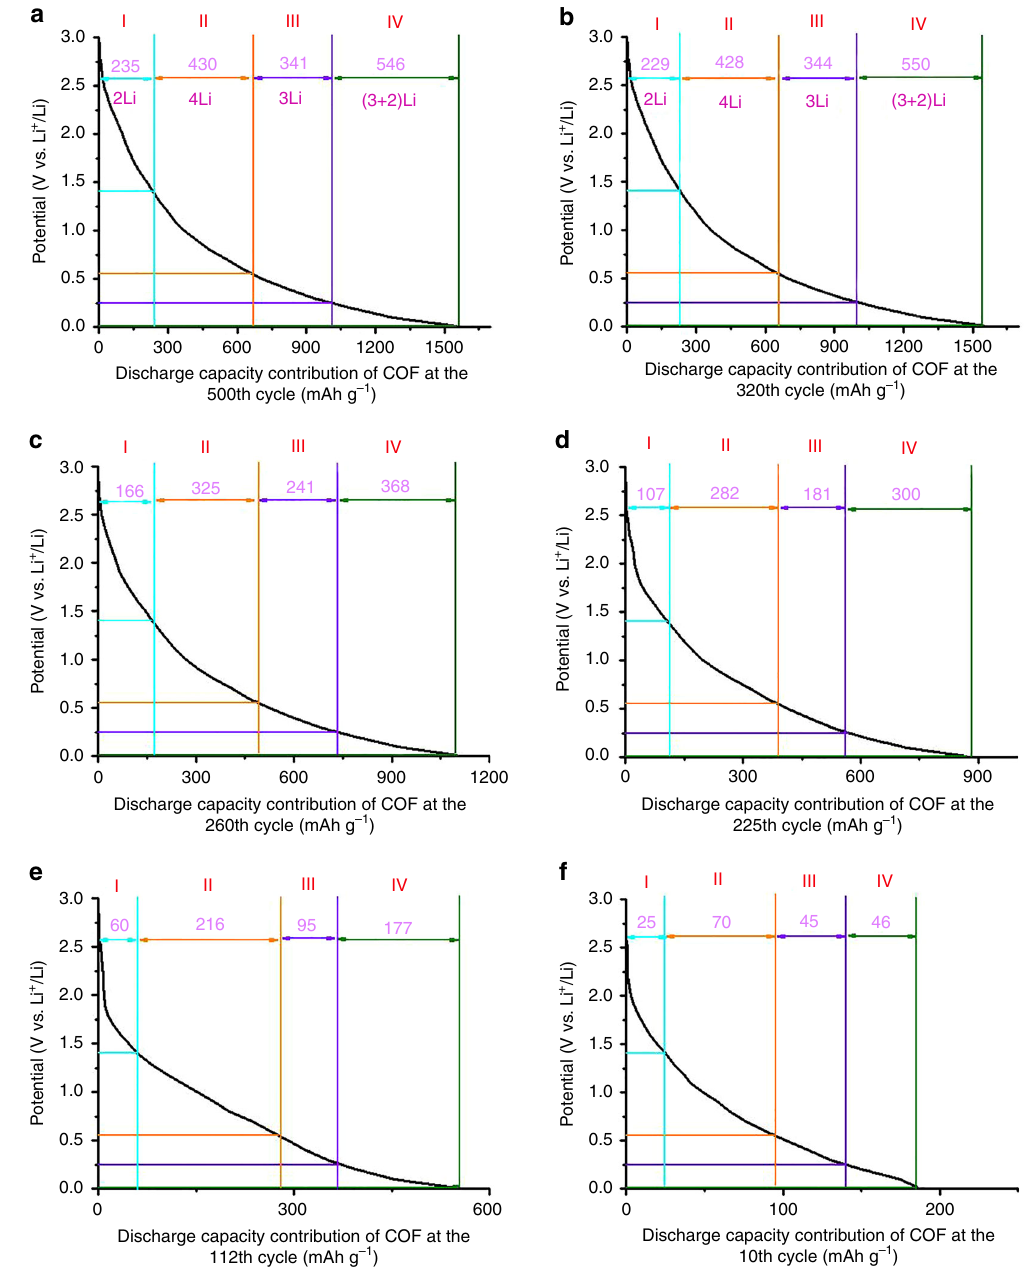
Fig. 9 Discharge curves of COF contribution in COF@CNTs anode. The discharge curve for COF contribution at the a 500th, b 320th, c 260th, d 225th, e 112th, and f 10th cycles with stepwise lithium-storage and the corresponding capacity contribution is